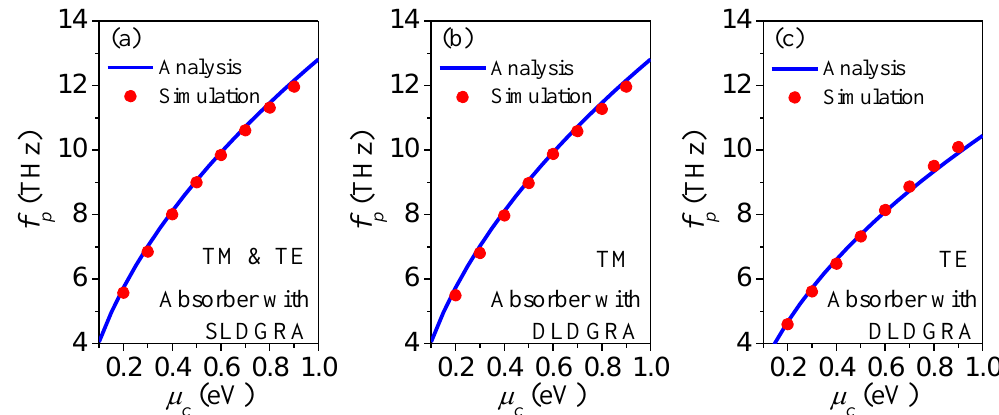
Figure 8. The variation of analytical and simulation absorbance peak frequency with different µ c ( a ) for the absorber with a SLDGRA under both TM and TE polarizations; ( b ) for the absorber with DLDGRAs under TM polarization, and ( c ) for the absorber with DLDGRAs under TE polarization.